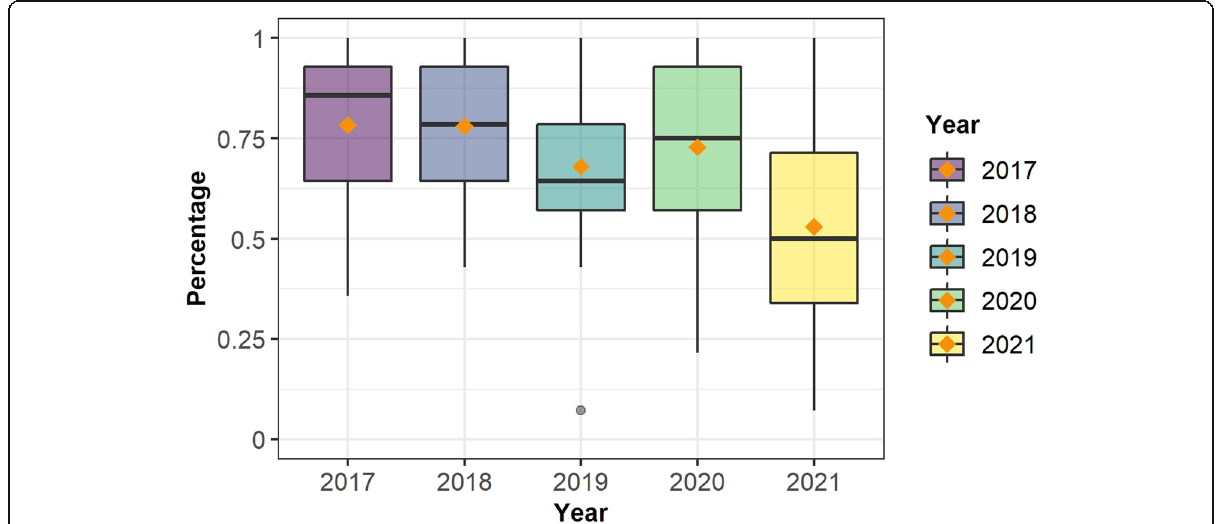
Fig. 2 Water Balance Model ’ s use scores (shown as percentages)